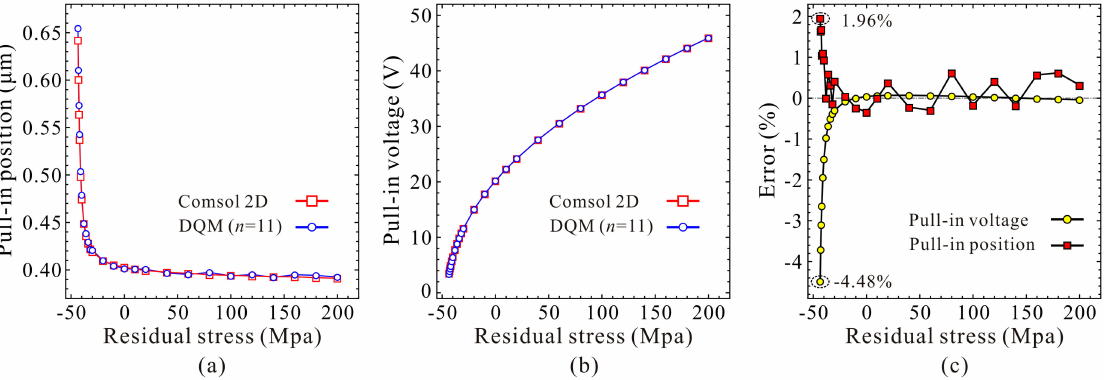
Figure 12. Quantitative property of the static pull-in voltage and pull-in position versus residual stress. Static pull-in position ( a ); Static pull-in voltage ( b ); Relative error ( c